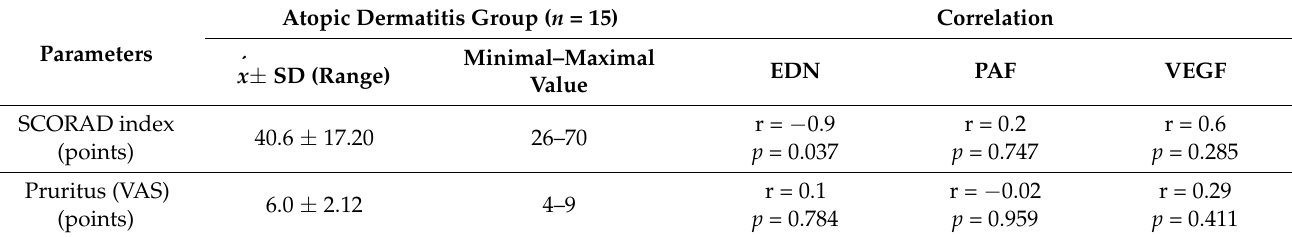
Table 3. Clinical characteristic of the examined patients with AD.